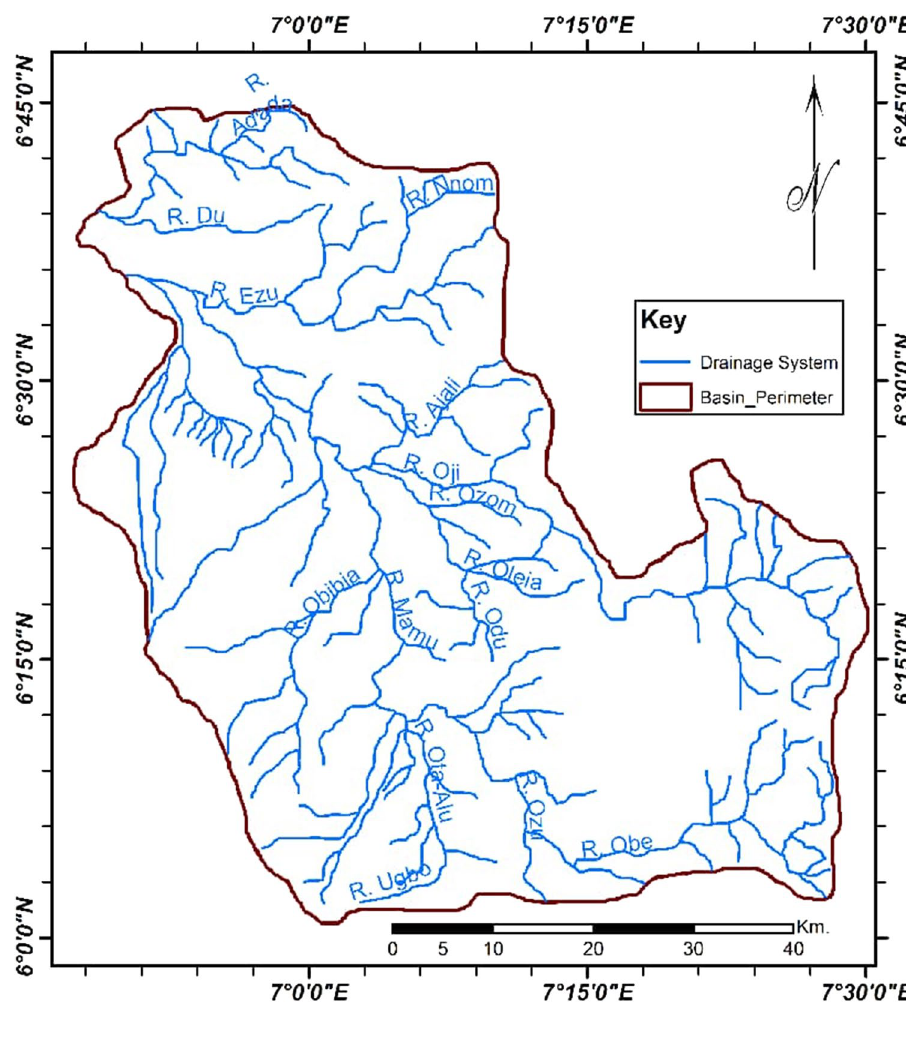
Fig. 4 The geology of the Anambra River